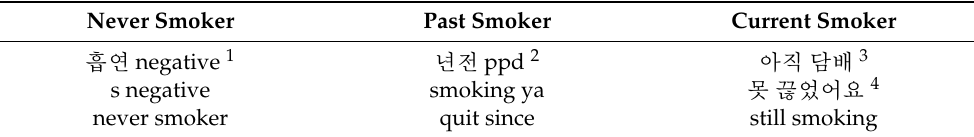
Table 4. Examples of extracted keywords. Both English and Korean keywords were simultaneously extracted for each of our seed keyword. The two bilingual keywords superscripted 1 and 2 translate to “smoking negative” and “years ago ppd (packs per day)”, respectively. The two Korean keywords superscripted 3 and 4 translate to “still cigarette” and “haven’t quit”,